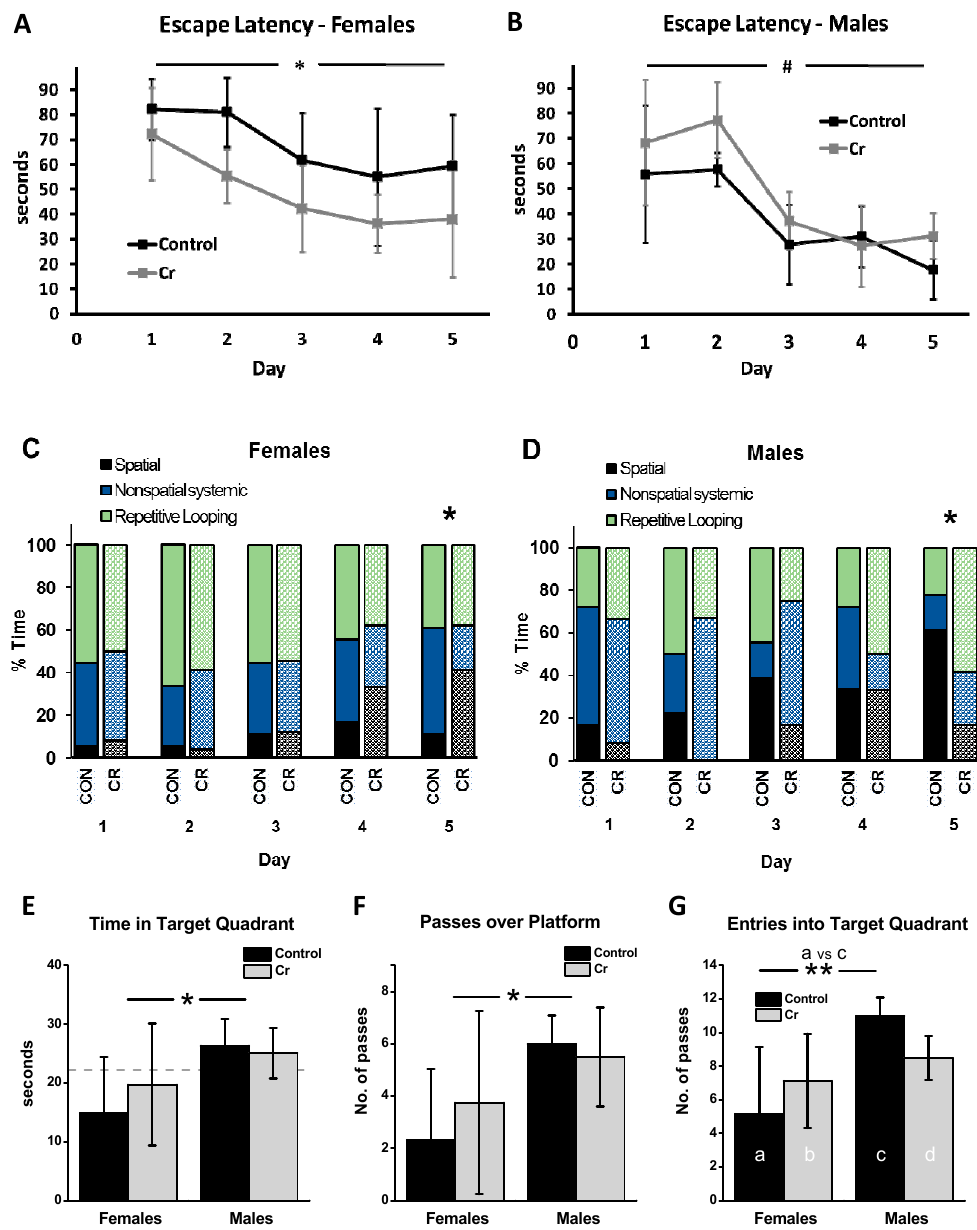
Figure 4. MWM (Morris water maze) as a function of diet in 3xTg mice. ( A – D ) Acquisition phase parameters as a function of diet in 3xTg mice. ( A ) In female mice, Cr supplementation significantly decreased escape latency (time to locate the platform; mean ± SD) overall across training days, indicating enhanced spatial earning; two-way ANOVA. ( B ) In males, however, Cr supplementation did not enhance performance in the MWM during training, as measured by escape latency, with a trend towards significantly greater escape latencies in supplemented males. ( C , D ) The frequency of use (% of total) of various search strategies (operationally defined as per [42]) was calculated across training days for control (solid bars) and Cr-supplemented (hatched bars) 3xTg mice and analyzed using Chi-square tests. ( C ) In females, reliance on spatial strategies increased with training in Cr-supplemented females, with the frequency of use peaking by the end of training, an e ff ect that was not seen in control-fed 3xTg females. ( D ) In males, however, a reverse pattern was noted, where Cr supplementation resulted in a decreased reliance on spatial strategies relative to those on the control diet. ( E – G ). Memory retention in the MWM. On the last (6th) day of training, the platform was removed and mice were allowed 90 s to swim. Memory retention (mean ± SD) was evaluated in control-fed and Cr-fed mice by measuring ( E ) time in the target quadrant, ( F ) passes over the platform